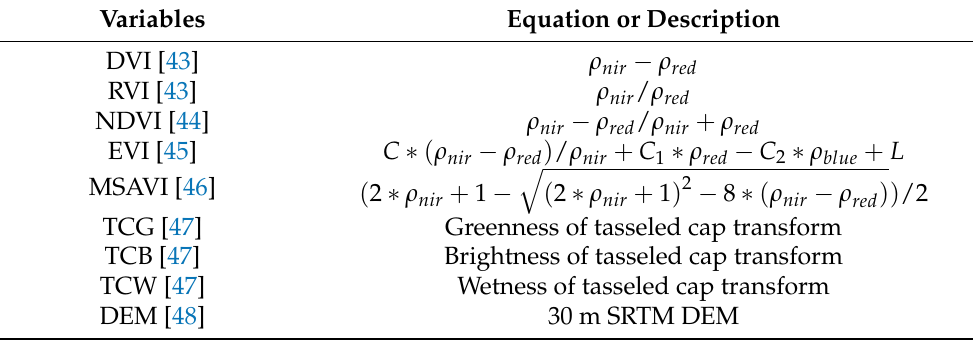
Table 1. Description of spectral indices for carbon density